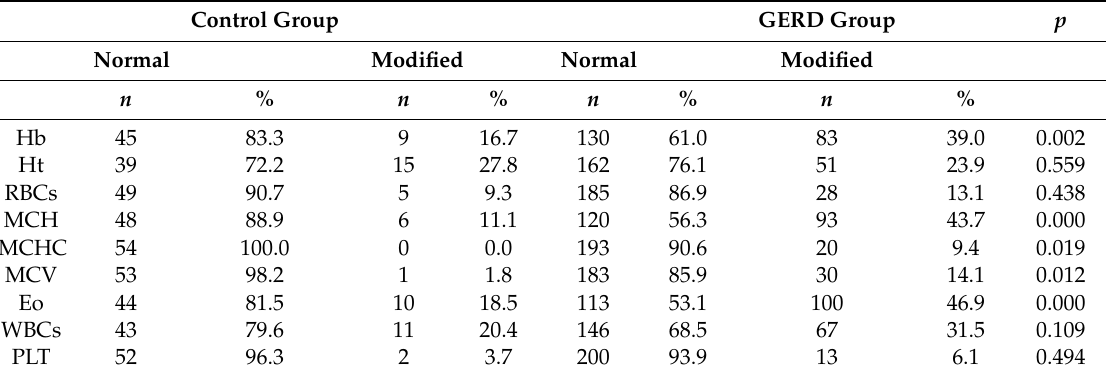
Table 1. Comparative study of ratios regarding patients with modified hematological parameters in the gastroesophageal reflux disease (GERD) group and the control group. Control Group GERD Group p Normal Modified